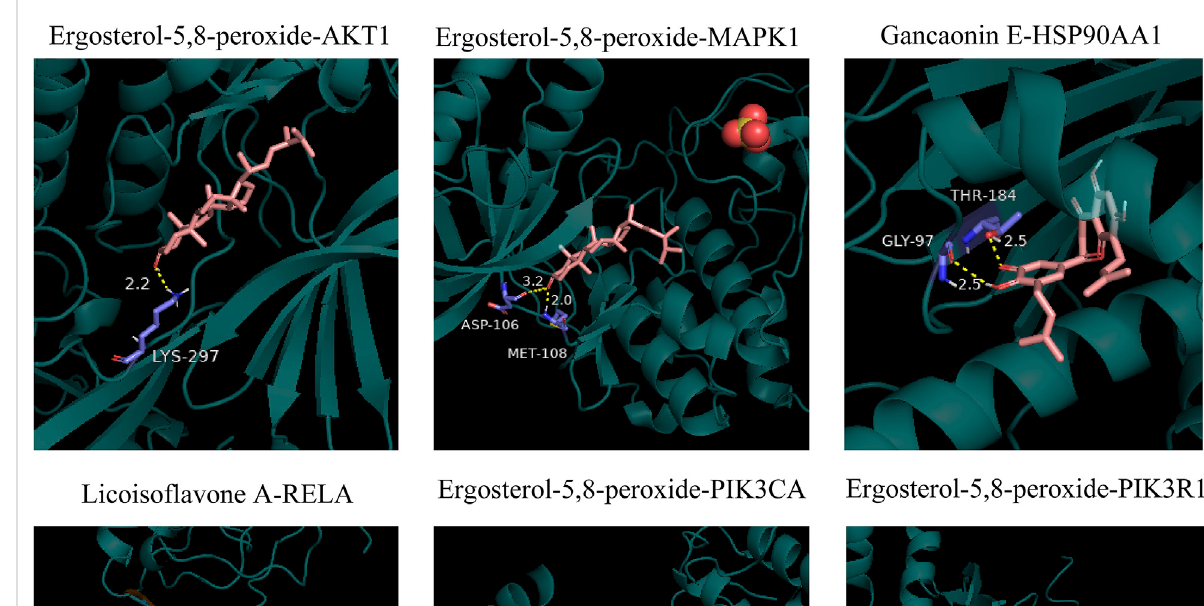
FIGURE 7 Schematic diagram of docking results between the core ingredients and the key targets.